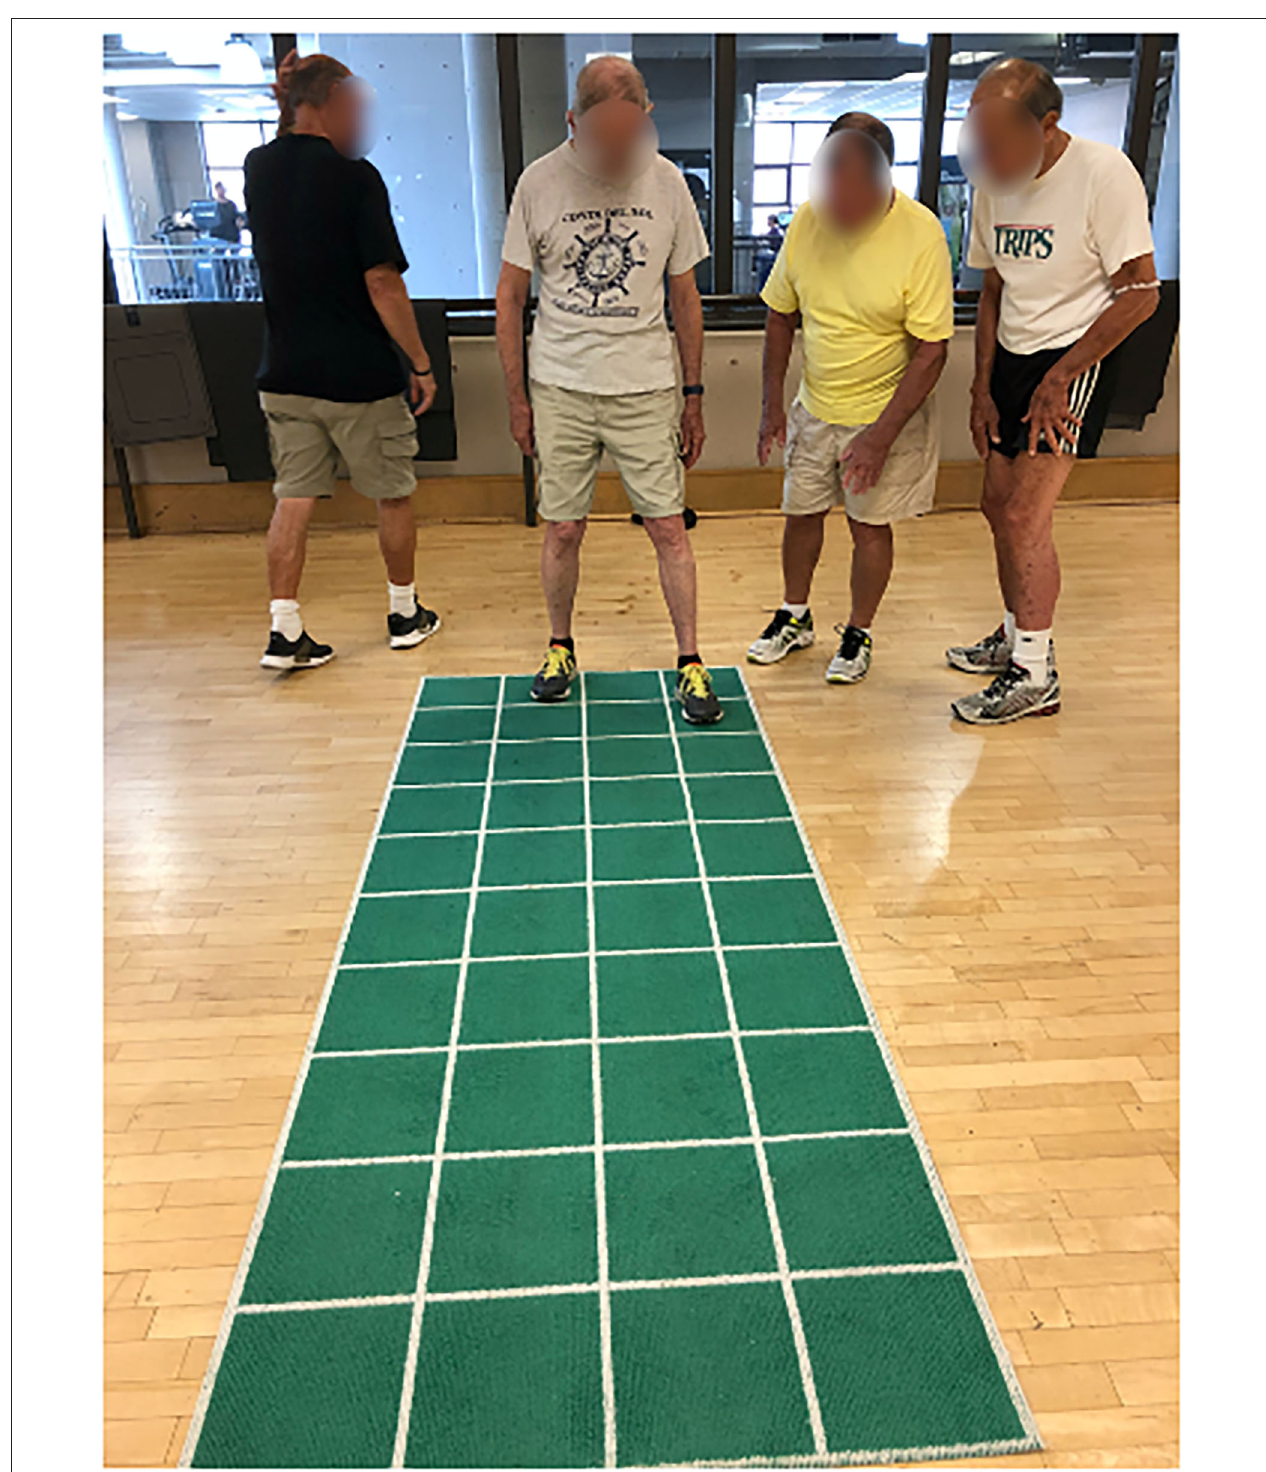
FIGURE 1 | Participants performing the square-stepping